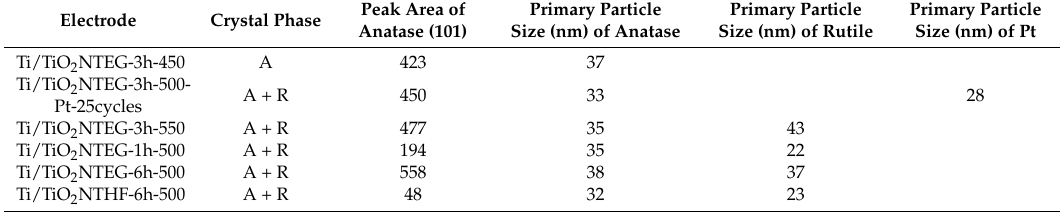
Table 1. Crystal phase, peak areas (101) of anatase and rutile phases, and primary particle sizes of the